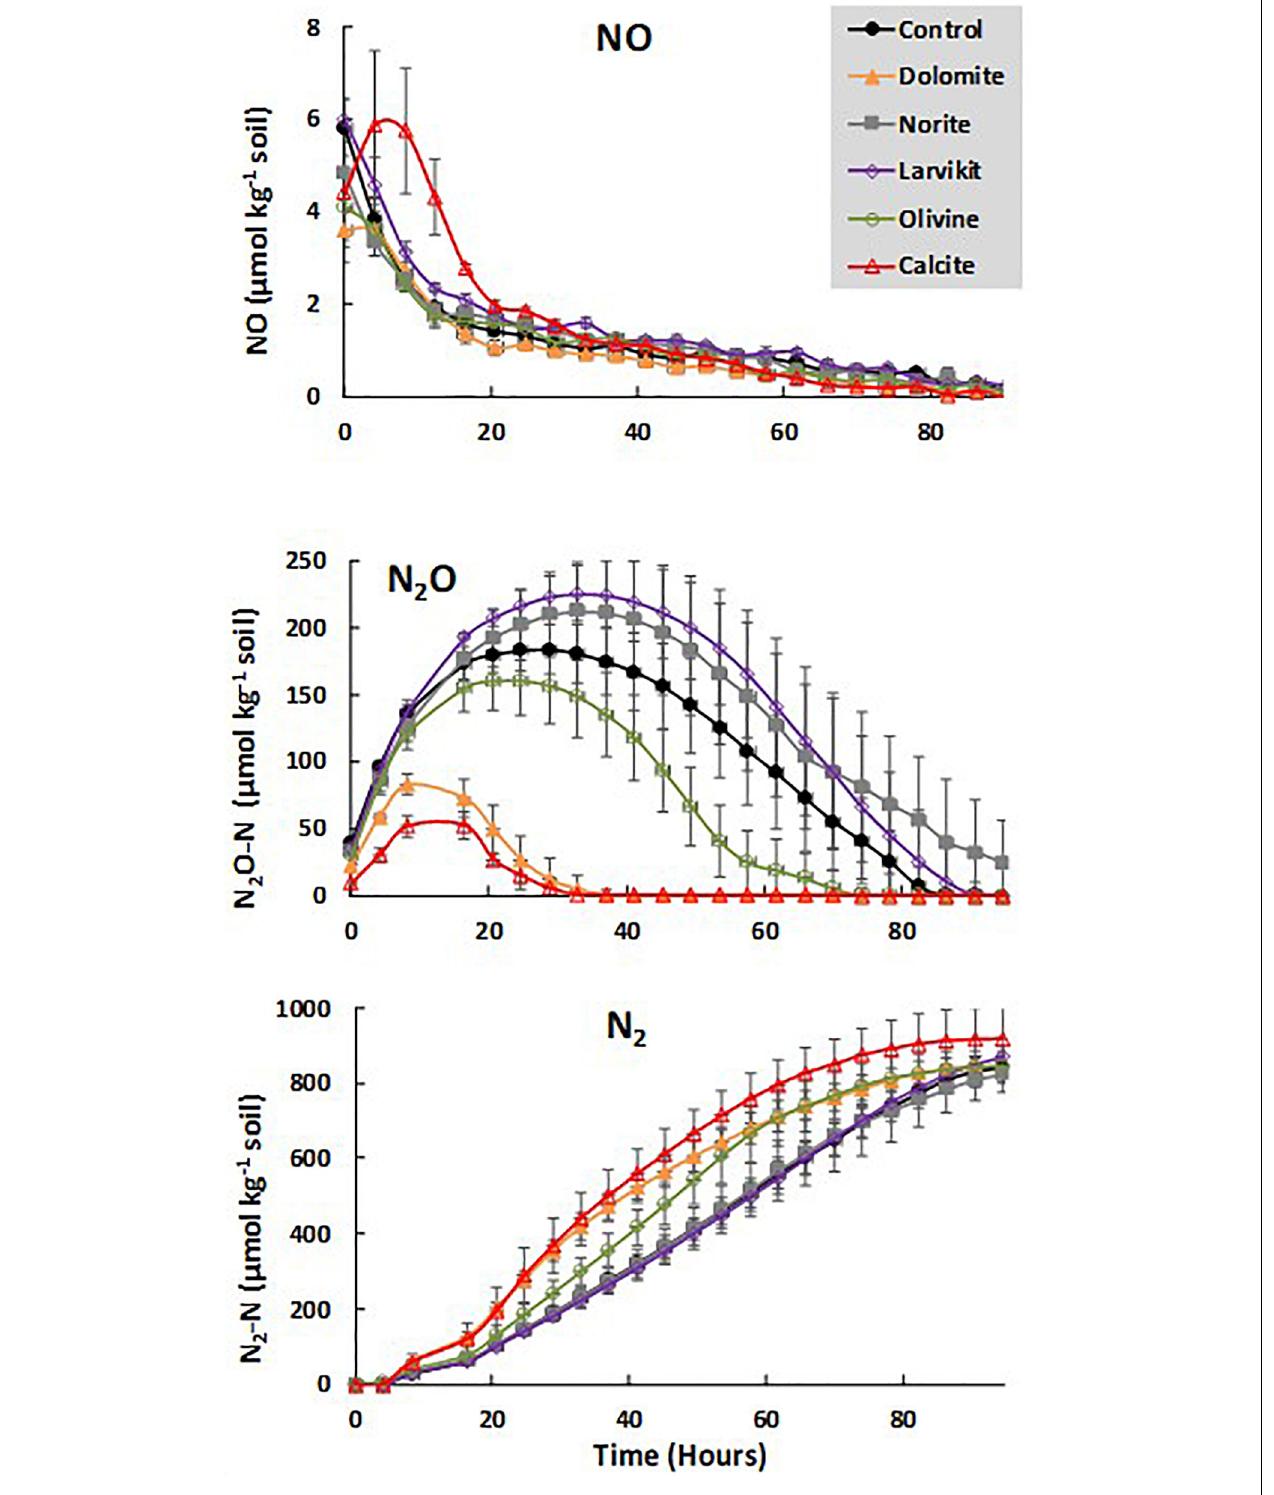
FIGURE 4 | Gas kinetics of denitrification in remolded soil under anoxic conditions. Plotted values are the means and standard error of four field replicates. Soil samples were collected in December 2016 (27 months after application of minerals).